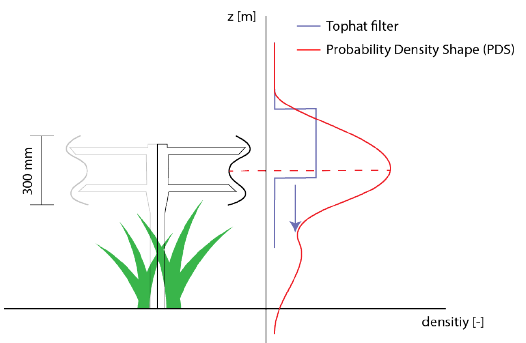
Figure 5. PDS of KDE along the z-axis with a Top-hat filter moving in the